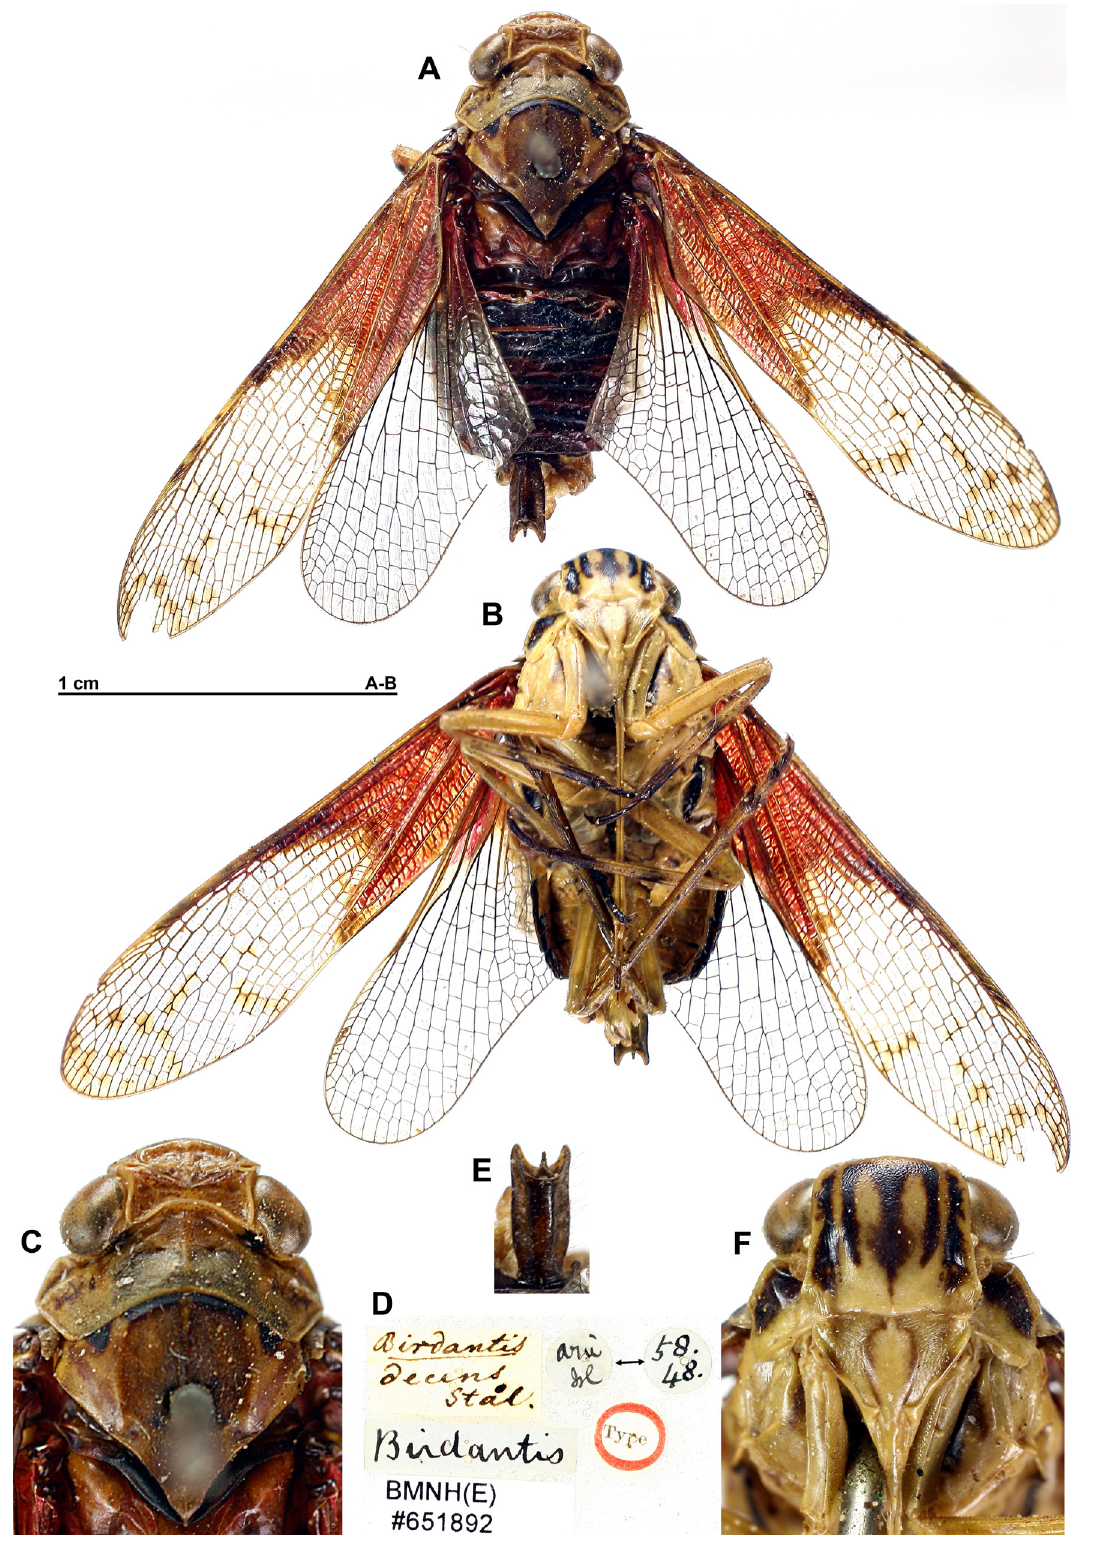
Fig. 5. Birdantis decens Stål, 1863, holotype, ♂. A . Habitus, dorsal view. B . Habitus, ventral view. C . Head and thorax, dorsal view. D . Labels. E . Anal tube, dorsal view. F . Head, normal view of frons. C–F not to